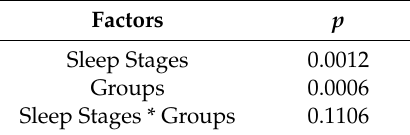
Figure 7. Boxplot of switching rate for three Groups. Table 3. Test of two-way ANOVA.